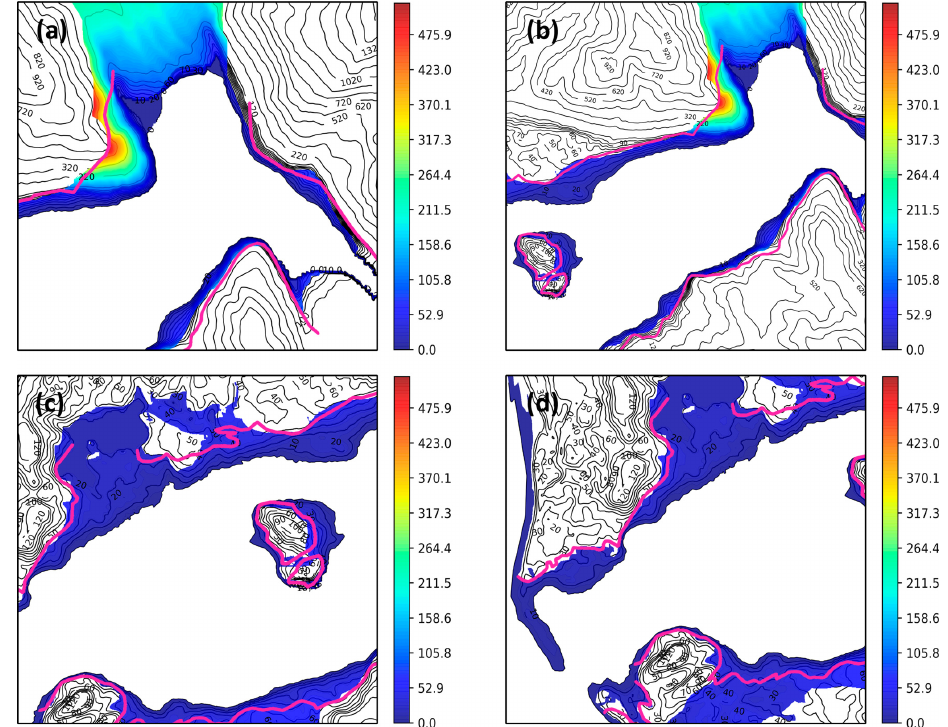
Figure 10. Images showing the four criteria used to select the optimal numerical solution and comparison of simulated optimal inundated area with the observed trimline. (a) Gilbert and Crillon inlets. (b) Inner part of the Lituya Bay from Cenotaph Island. (c) Fish Lake and Cenotaph Island area. (d) Entrance of the bay up to Cenotaph